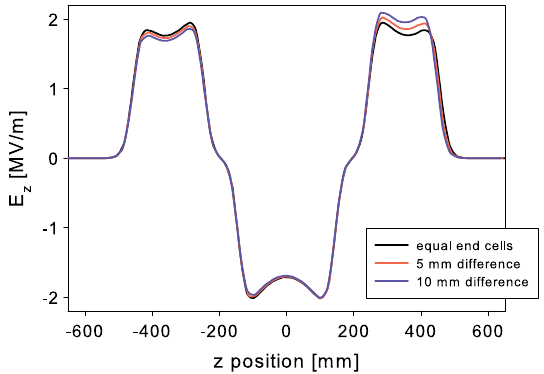
FIG. 40. On-axis electric field profile for equal end cell lengths and an imbalance of 5 and 10 mm for a double-spoke cavity with cylindrical spokes, operating at 325 MHz. The imbalances are created by adding length to one end cell while keeping the spokes